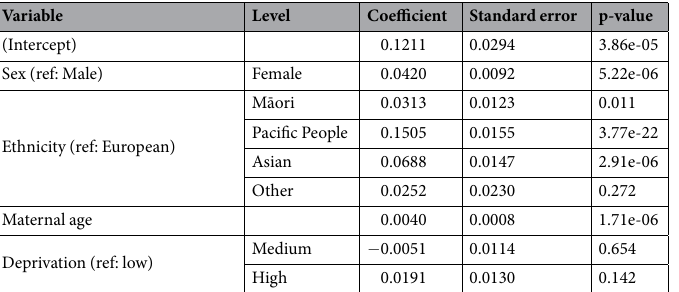
Table 3. Multivariable analysis with the model: log(T/S) ~sex + ethnicity + maternal age + deprivation. All 5 categories of ethnicities (European, Māori Pacific People, Asian and Other) were included in the analysis.